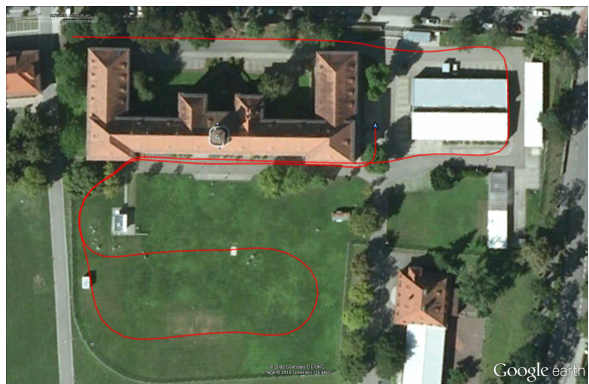
Figure 3. Path driven by the sensor vehicle during the data ac- quisition (Image data: Google Earth, Image c (cid:13) 2014 GeoBasis- DE/BKG).